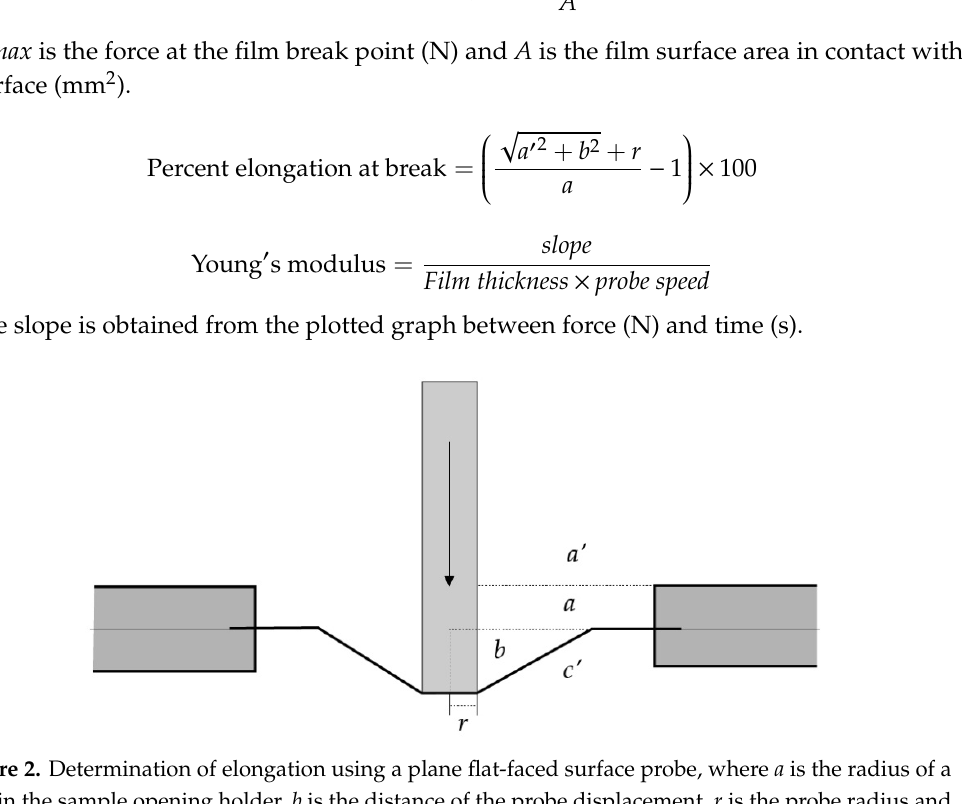
Figure 2. Determination of elongation using a plane flat ‐ faced surface probe, where a is the radius